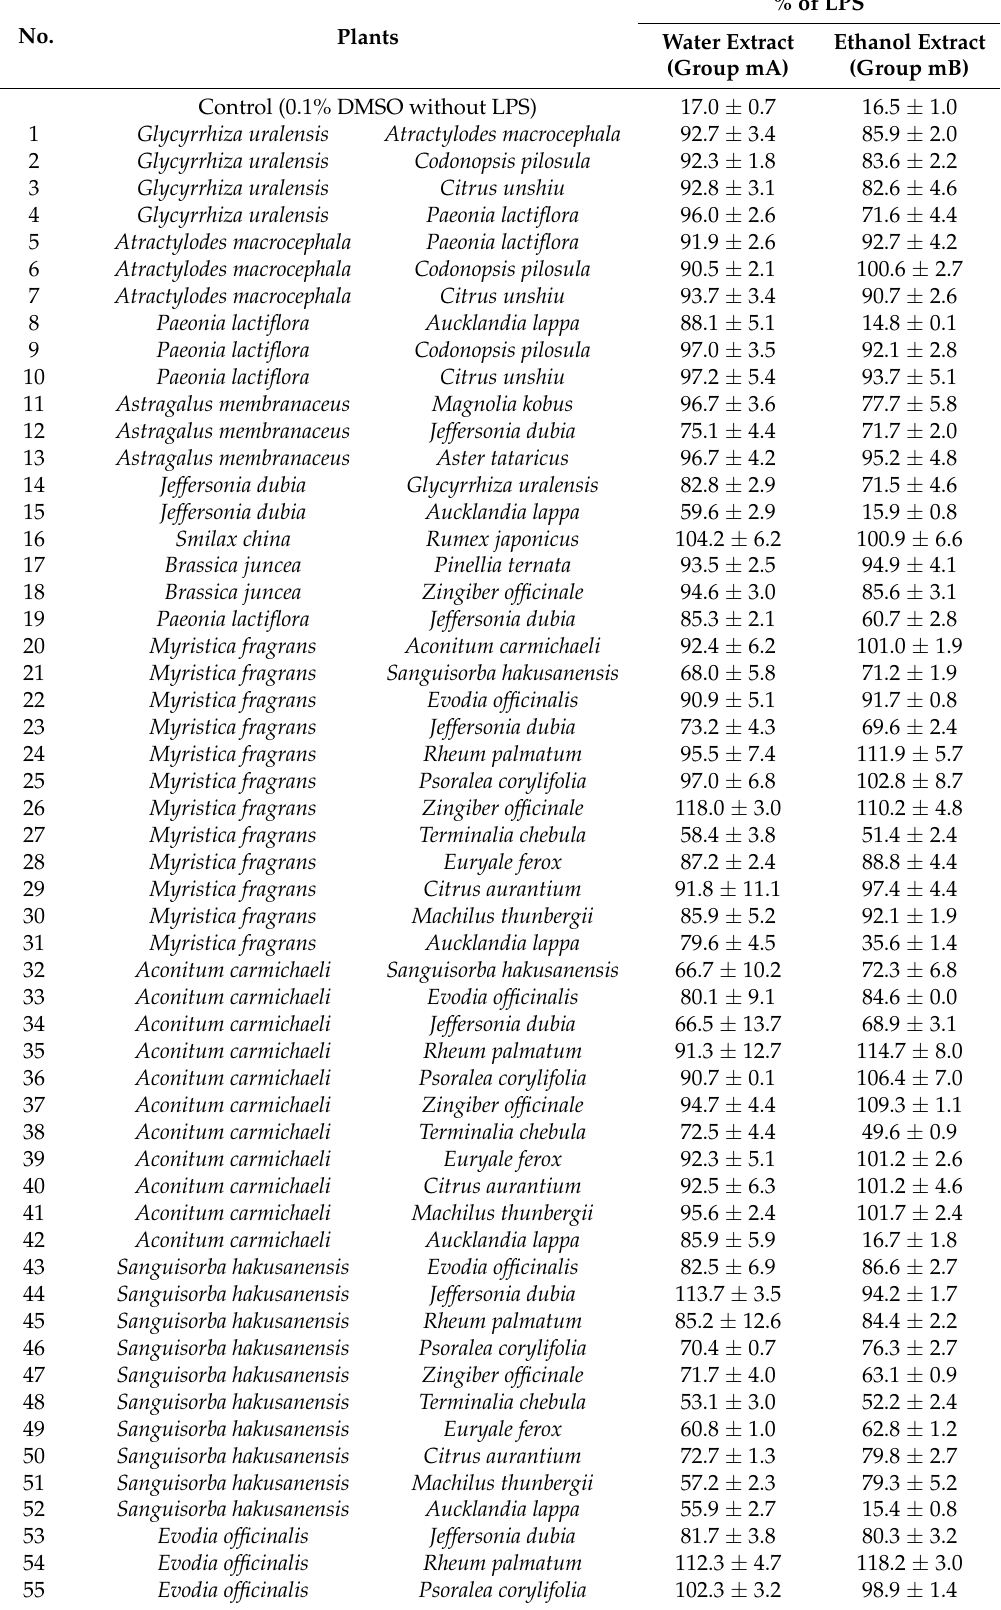
Table 2. NO assay results of the extracts of 1:1 mixtures of two